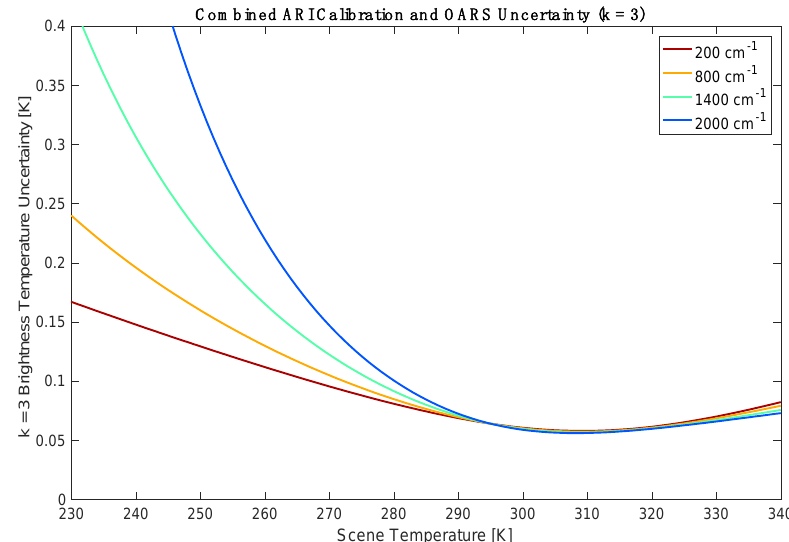
Figure 8. Predicted laboratory combined radiometric calibration and verification uncertainty (k = 3).